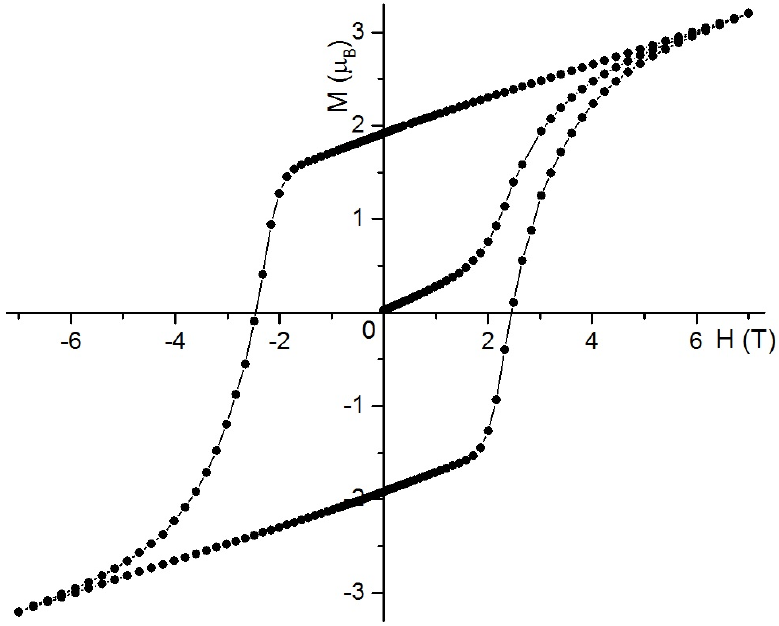
Figure 5. Initial magnetization vs field plot and magnetic hysteresis (inset) for 1 at T = 1.8 K.